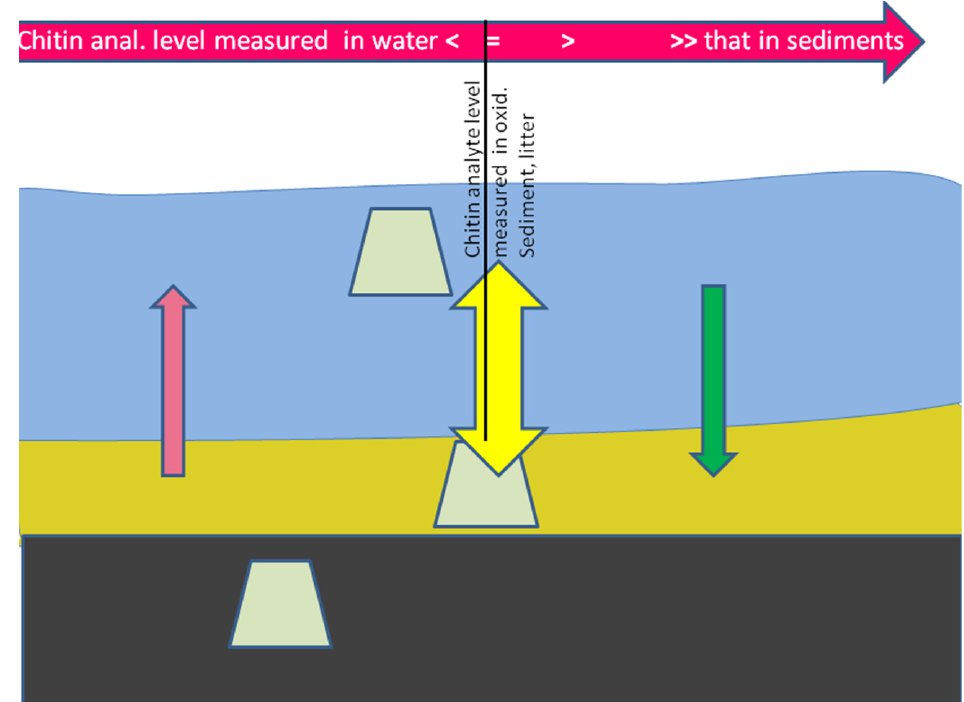
Figure 3. Partition of element ion sorbates on chitin immersed in water (top) and in wet sediment (bottom). Chitin flakes are located so close to each other that equilibrium (yellow double arrow) can be expected (not implying levels of a given element on flakes in water and in sediment are equal) unless there are subsurface processes absorbing metals into or releasing them from the sediment. Black: anoxic sediment layer where there is sulfate reduction mobilizing Ba, Pb (direction of pink arrow), and Cp. [12].